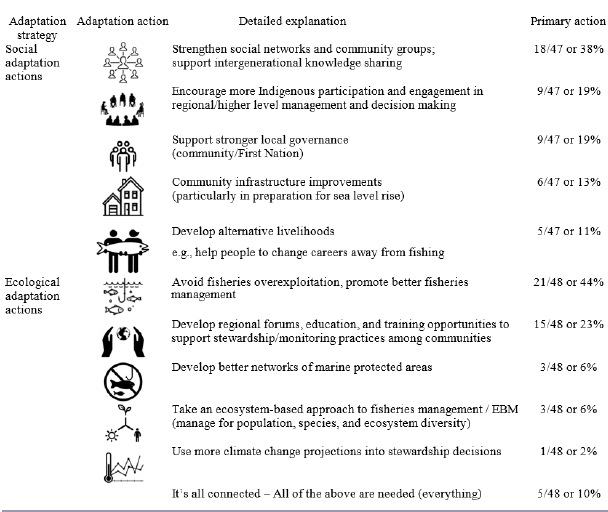
Figure 3 . Adaptation strategies, descriptive icons used during interviews, detailed explanations, and proportions who selected certain actions as the primary effective adaptation strategy (48 participants spoke to the topic of ecological adaptation strategies, and 47 to the question of social adaptation strategies.) EBM: ecosystem-based management. Icons courtesy of